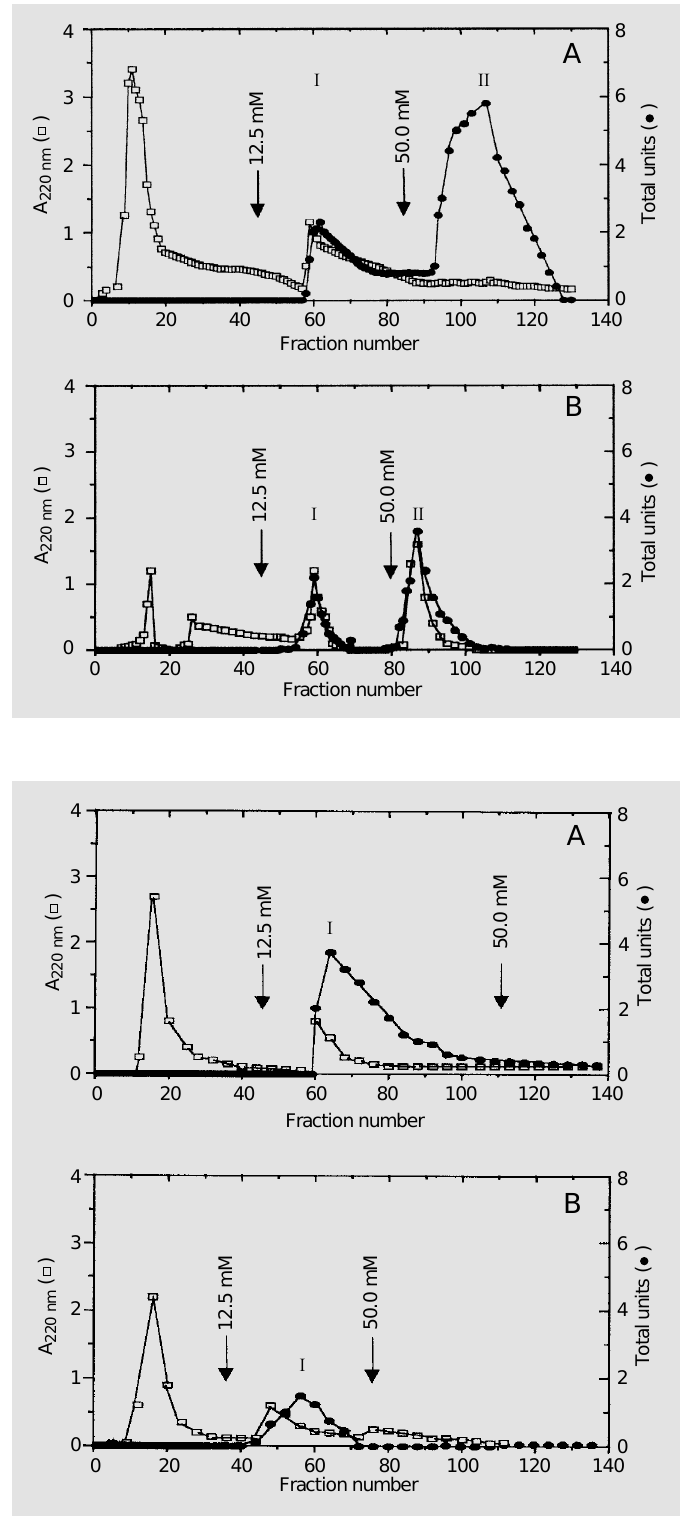
Figure 1 - Stepwise elution from DEAE-cellu- lose of constitutive alkaline phosphatases synthesized by the wild 74A strain of N. crassa grown in high-Pi medium at 30 o C, pH 5.4, and supplemented with 44 mM acetate (A) or 44 mM sucrose (B) as the carbon source. After elution of non-absorbed pro- teins, enzyme was eluted by the stepwise addition of 12.5 and 50.0 mM KCl in 10 mM Tris-HCl buffer, pH 8.8, containing 40 mM MgSO 4 . For details, see Material and Meth- ods.